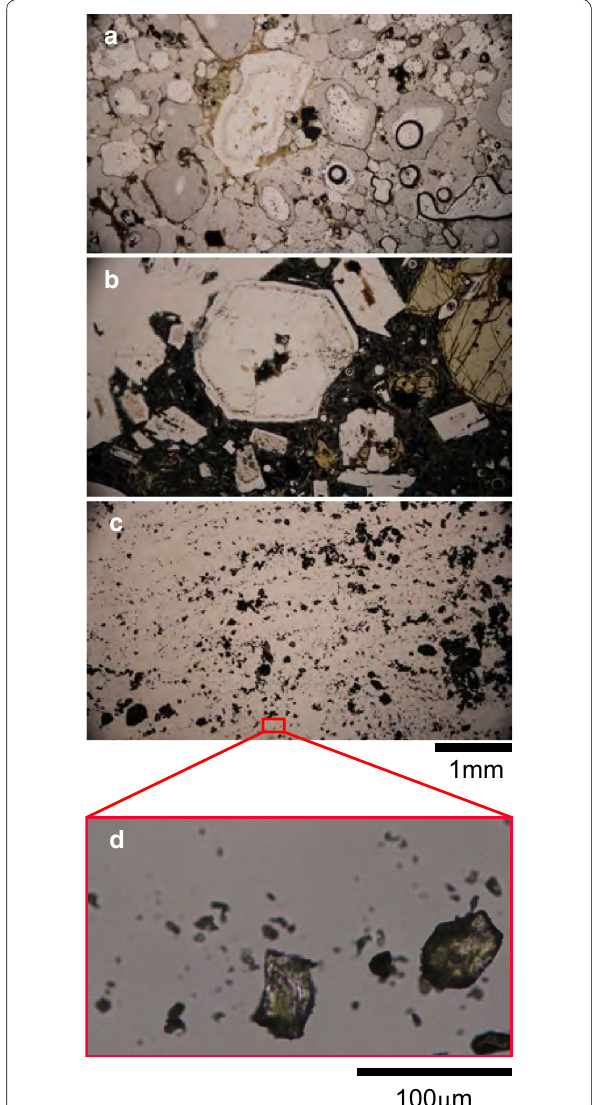
Fig. 3 Thin section images of a scoria and ash. a Open nicol image of a typical high-porosity scoria (Fig. 2a). b Open nicol image of the molten scoria shown in Fig. 4f. c Ash observed by a microscope showing the existence of fine ash < 63 µ m . d Magnified view of ( c